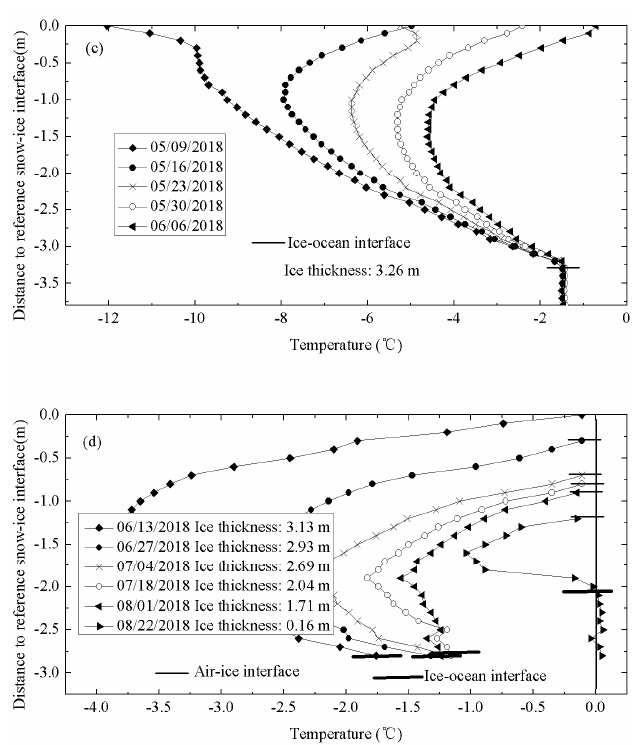
Figure 3. The vertical temperature profiles (resolution of 0.10 m) through air, snow, sea ice, and upper ocean measured by IMB-2007E. ( a ) Typical top profiles (12 points) were obtained from 3 January to 2 May (freezing period). ( b ) Typical profiles under the initial ice surface were obtained from 3 January to 2 May (freezing period). ( c ) Typical profiles under the top interface were obtained from 9 May to 6 June (warming period). ( d ) Typical profiles under the initial ice surface were obtained from 13 June to 22 August (melting period).